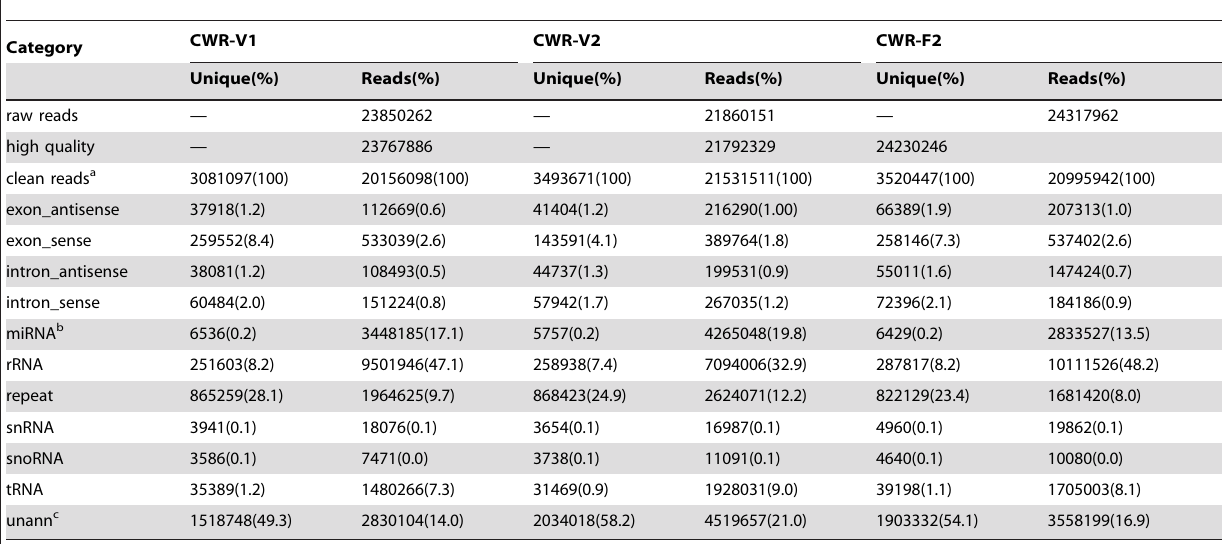
Table 1. Distribution of different sRNA categories in the different